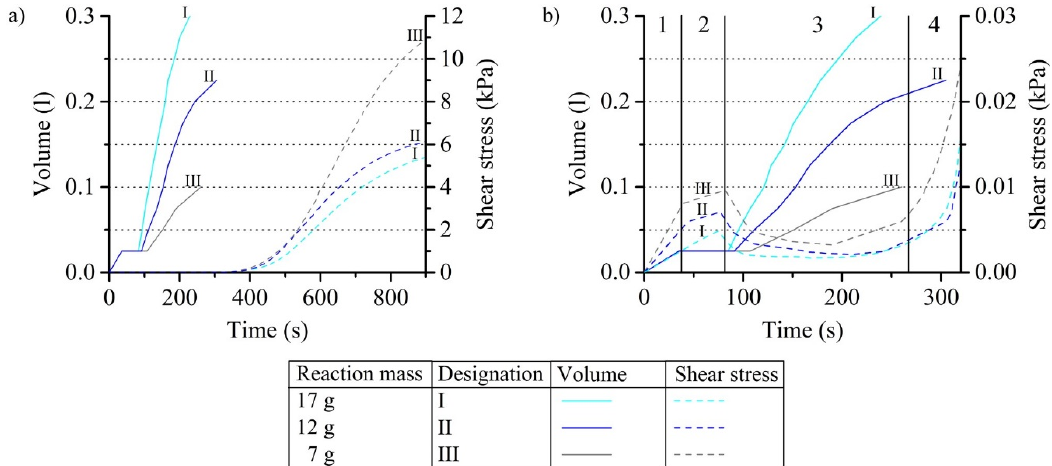
Figure 5. Influence of the PUR reaction mass on the shear stress within reacting PUR foam considering the volume expansion ( a ) during the complete curing time and ( b ) in detail of the first 320 s with four measuring phases: 1—component mixing, subsequent filling in and nucleation, 2—lying time, 3—cell growth and volume expansion, 4—curing.